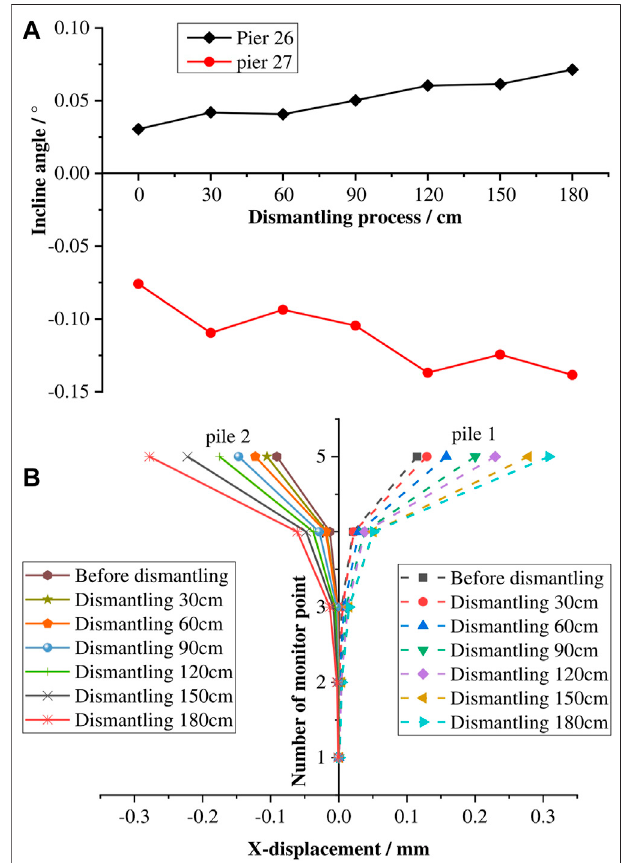
FIGURE 11 | Deformations of piers and piles during the dismantling process of temporary lining: (A) Change in inclination of piers; (B) Horizontal displacement of